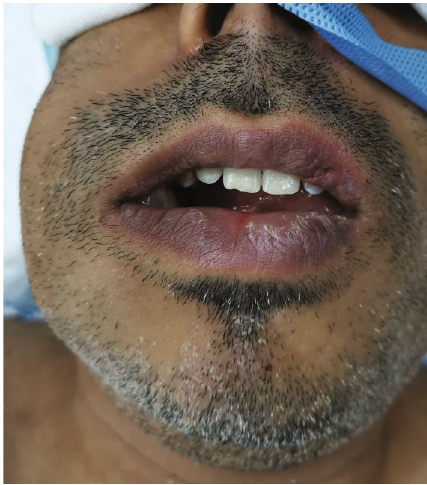
Figure 1: Extraoral photograph of the patient showing swelling on right side of the face.